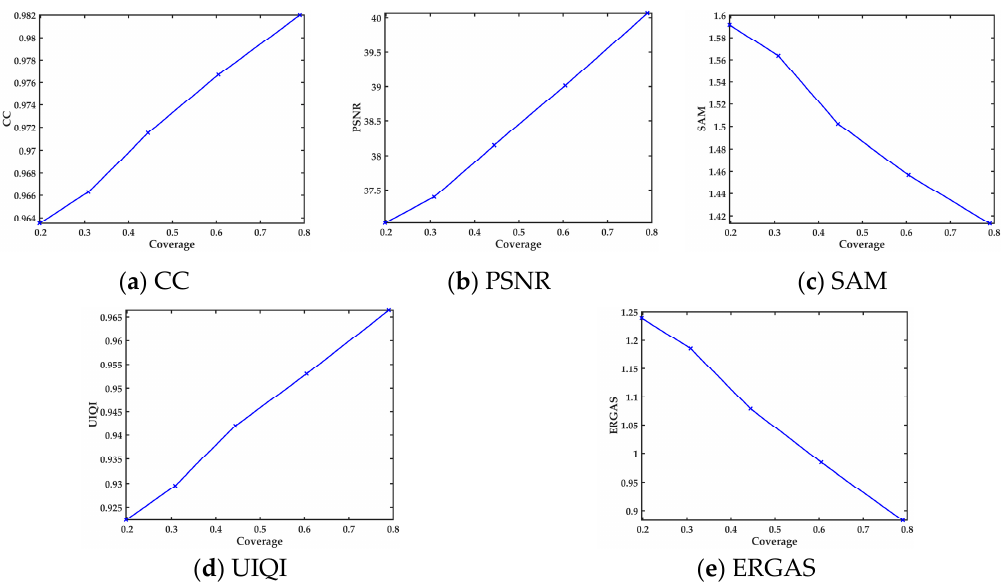
Figure 8. Quantitative evaluation results for different offset positions.